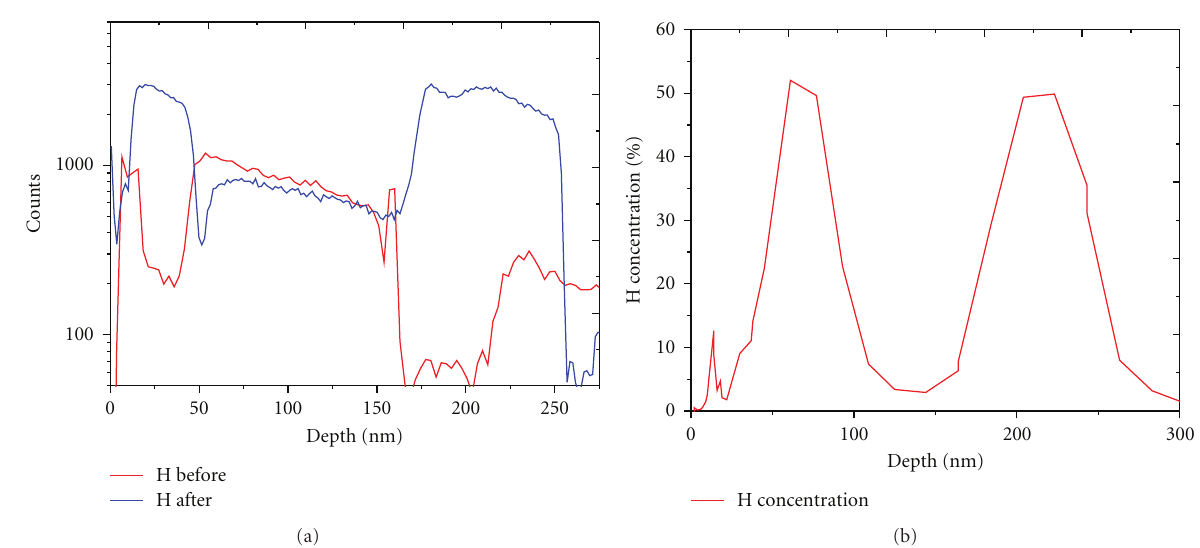
Figure 6: Comparison of H profiles for the sample Pd/Ti/TiO 2 /Ti/Si measured by SIMS (a) and N-15